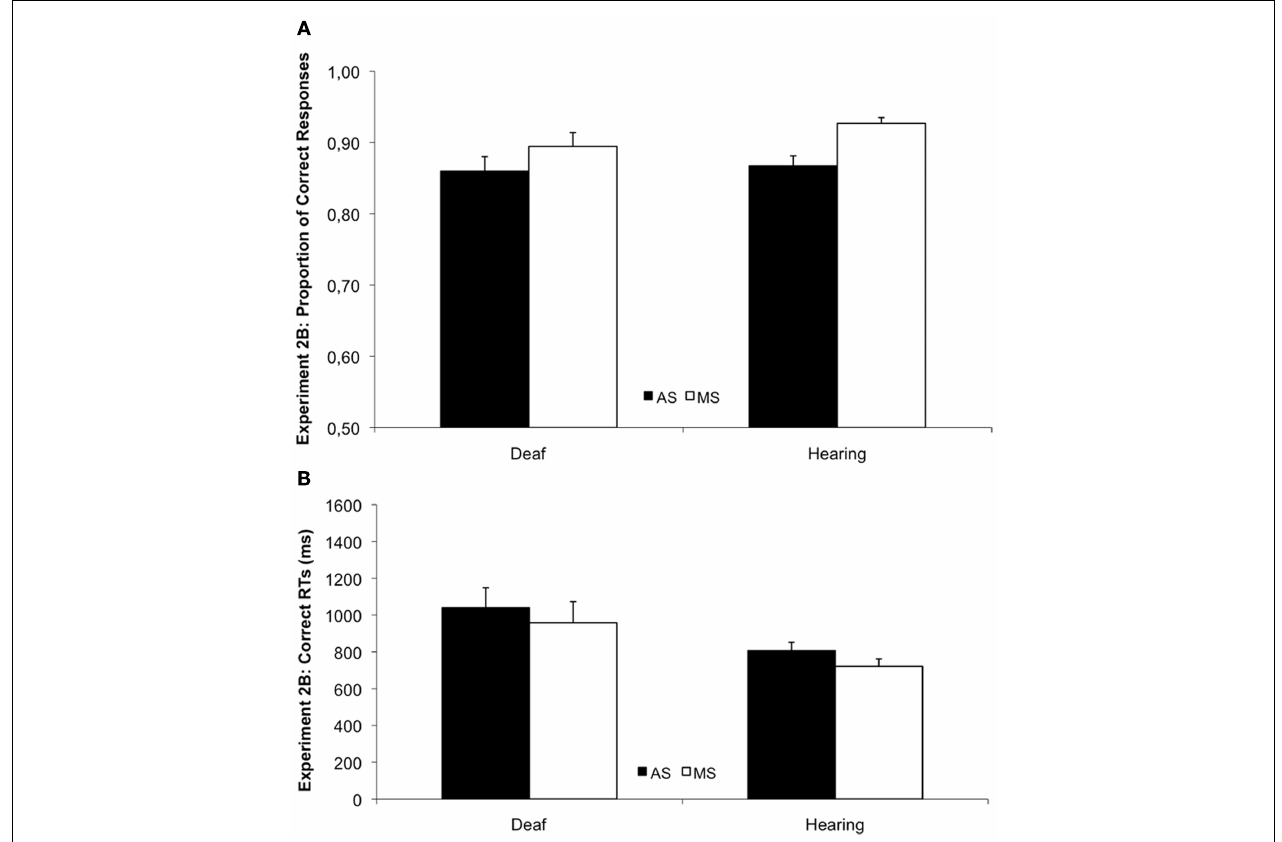
FIGURE 7 | Proportion of correct responses (A) and correct response times (B) of deaf and hearing participants when the locus of attention was the bottom parts of faces (Experiment 2B). Bars represent SEs.